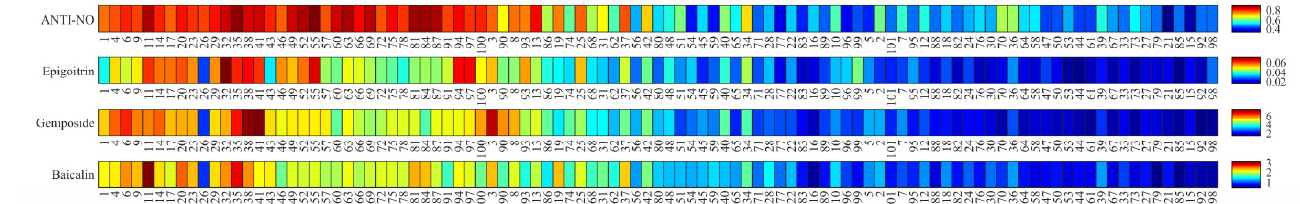
Figure 2. Heat map of 4 chosen targets.